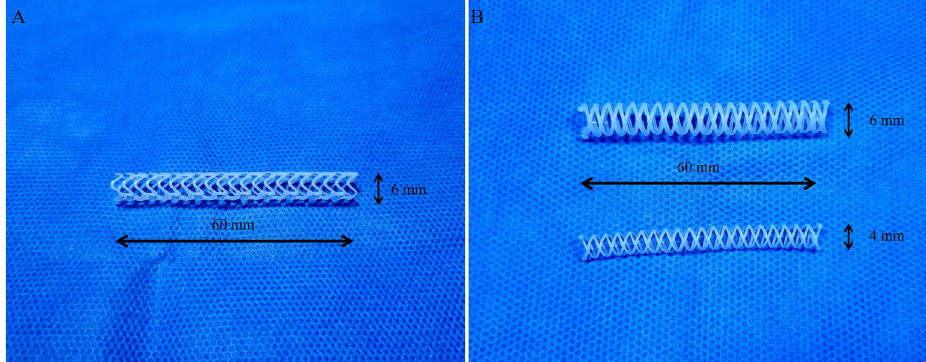
Figure 1. 3D-printed polycaprolactone biliary stents. ( A ) Prototype stent. ( B ) Final version